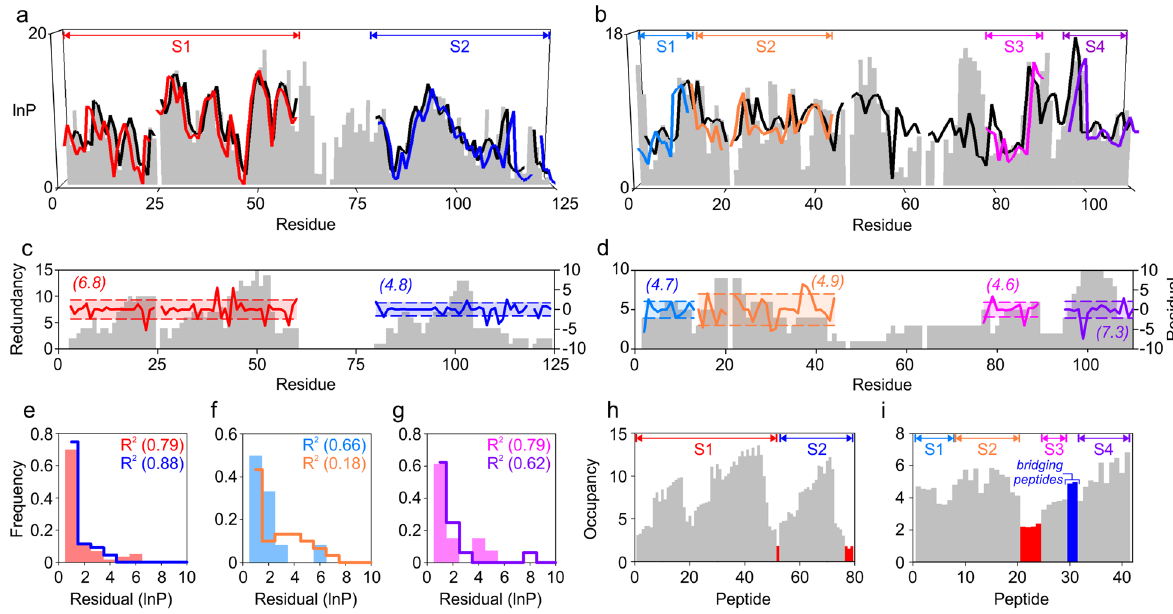
Fig. 1 Example optimisation outputs for HDXmodeller. a , b Comparison of reference and model lnP values built onto experimental peptide maps obtained for alpha lactalbumin ( a ) and barnase ( b ). Reference lnP values are shown as grey bars and model lnP are also shown for the whole submission (black lines) or subsections (coloured lines) as the median values across all optimisation replications. Different subsection submissions are denoted (S), breaks in the plots occur from missing data or from proline residues. c , d Comparison of the residue redundancy and lnP residuals of alpha lactalbumin ( c ) and barnase ( d ). Redundancy is shown as grey bars (right axis scale) and the residual lnP are shown as coloured lines as displayed in ( a , b ) (left axis scale). Shaded area represents the RMSE of the residuals for each subsection and the average redundancy for each subsection is also given in parenthesis ( n = 100). e – g Residual histograms for data shown in ( a , b ) with data colouring matching the respective subsections. The R 2 between the reference lnP and the median model lnP are also shown in parenthesis. h , i Peptide occupancy for alpha lactalbumin ( h ) and barnase ( i ) data shown in ( a , b ). Peptides for different subsections are denoted (S), red bars indicate peptides with an occupancy threshold below the 2.5 cut off, blue bars denote bridging peptides that were deleted to create subsections S3 and S4 (Supplementary Fig.